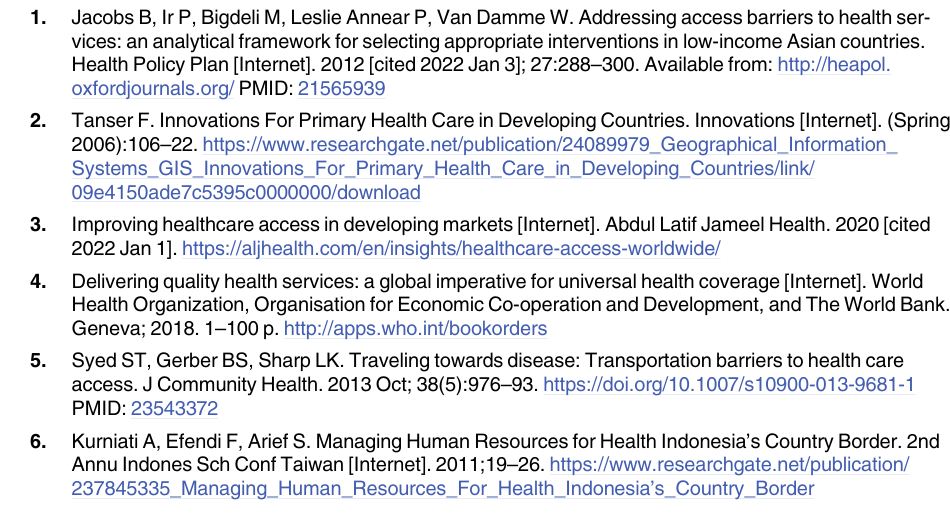
S7 Table. Network analysis results and raw data providing the number of routes and dis- tances required for citizens to travel from the nearest dock or port to the nearest port clos- est to a hospital (on another island). S8 Table. Number of health care workers (physicians, nurses, and midwives) by healthcare facility (puskesmas and hospitals) by district in Maluku Province. S9 Table. Overall healthcare capacity (total number of physicians, nurses, and midwives) by district, hospital (within district), and puskesmas (within district). S10 Table. Overall distance (km), type, and condition of road networks by government administrative